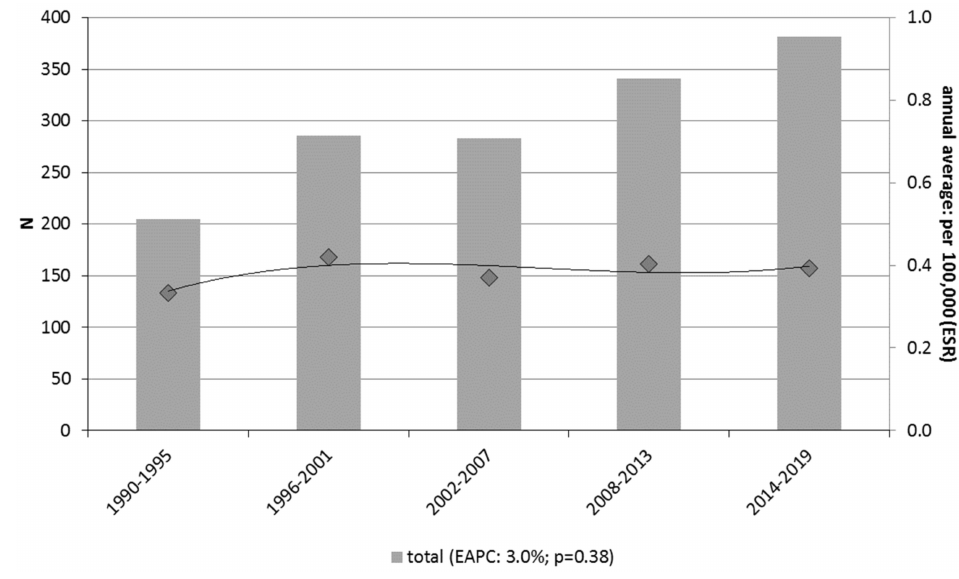
Figure 2. Crude numbers (bars, left axis) and annual averaged, age-adjusted incidence rates (line, right axis) for patients with mucosal melanoma in the Netherlands.